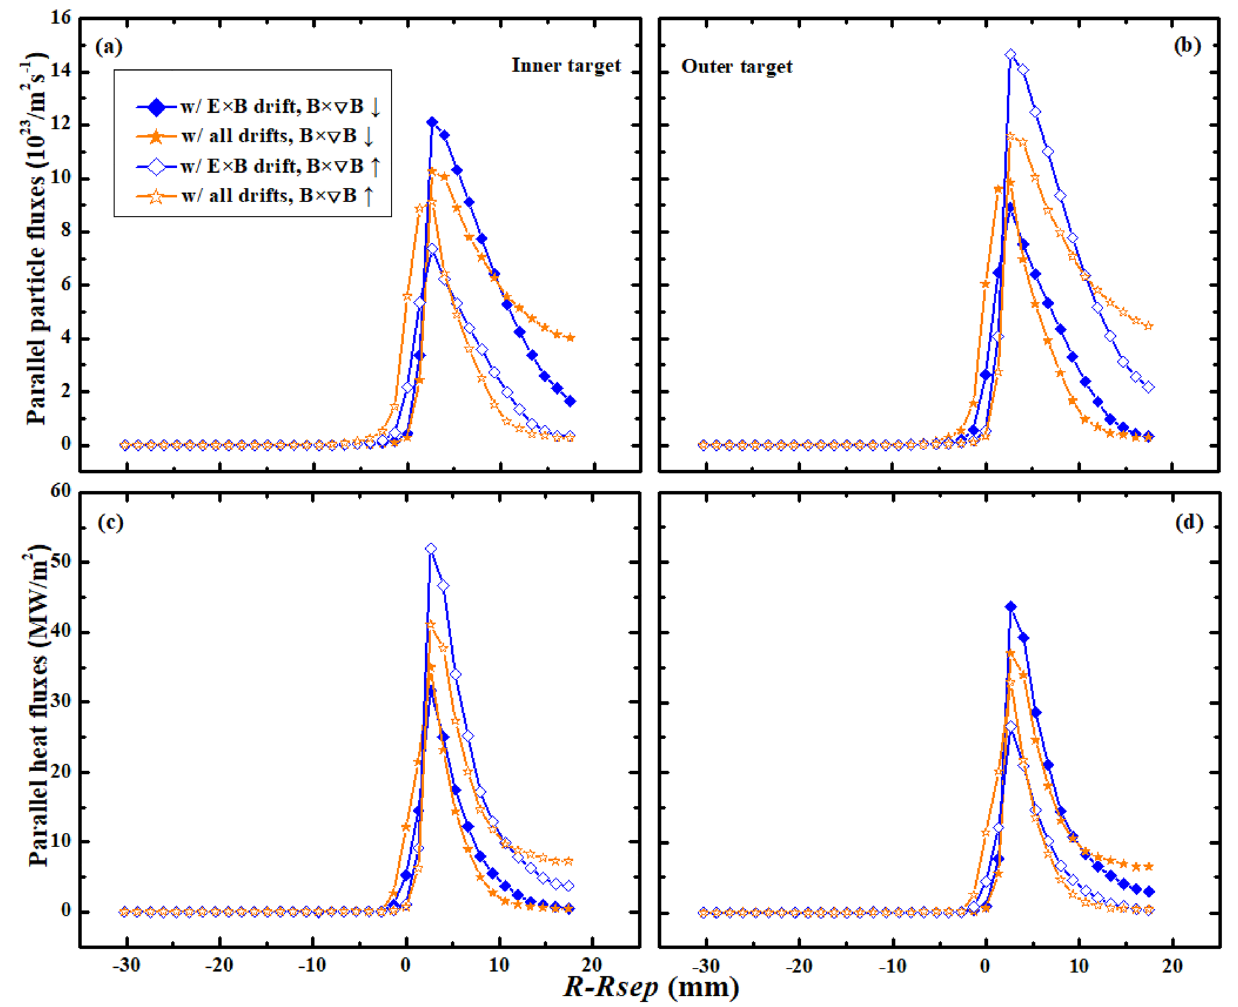
Figure 7. The particle and heat fluxes at the inner and outer targets for cases with only E × B drift and cases with all drifts under normal and reversed toroidal magnetic The number is 2.09 × 10 20 for the case with reversed toroidal magnetic field. The numbers of particles across separatrix by E × B drift for the two cases are much larger than the counterparts that caused by the diamagnetic drift in previous simulation cases with diamagnetic drift. The above simulations are done either with only diamagnetic drift or with only E × B drift. To study the effects of all drifts on the DOIAs of particle and heat fluxes, two simulation cases with normal and reversed toroidal magnetic field respectively, are done with all drifts switched on. Figure 7 shows the simulated particle and heat flux profiles at the inner and outer targets for the two cases along with the counterparts from cases with only E × B drift. For cases with normal toroidal magnetic field, the peak particle flux is smaller at the inner target while larger at the outer target in case with all drifts compared to that of with only E × B drift. The particle flux decay widths (cid:31) js at both inner and outer targets for the two cases seem to have opposite relationships compared with the peak particle flux. Meanwhile, the peak heat flux and the heat flux decay width (cid:31) q show reversed DOIAs with the counterparts of particle fluxes for the two cases. For the cases with reversed toroidal magnetic field, both the peak particle and heat flux and the flux decay widths between case with only E × B drift and case with all drifts have reversed relationships compared to those of the normal toroidal magnetic field. To study in detail on the DOIAs of particles and energy for these cases, the total particles and energy to the inner and outer divertor targets are calculated and shown in Table 3. As can be seen, the total particles and energy to both the inner and outer targets are larger in cases with only E × B drift than those of without drifts, indicating that the E × B drift could bring net particles and energy to the divertor targets, which is different from the diamagnetic drift. The total particles and energy to the inner and outer targets for the cases with all drifts are similar to the counterparts from the cases with only E × B drift, indicating that diamagnetic drift doesn’t have much effect on the DOIAs of total particles and energy, which has also been confirmed in the comparison between cases without drifts and with only diamagnetic drift. The data in Table 3 also show that the DOIAs of total particles and energy are reversed with the reverse of toroidal magnetic field, and the DOIA of energy is opposite to that of the particles